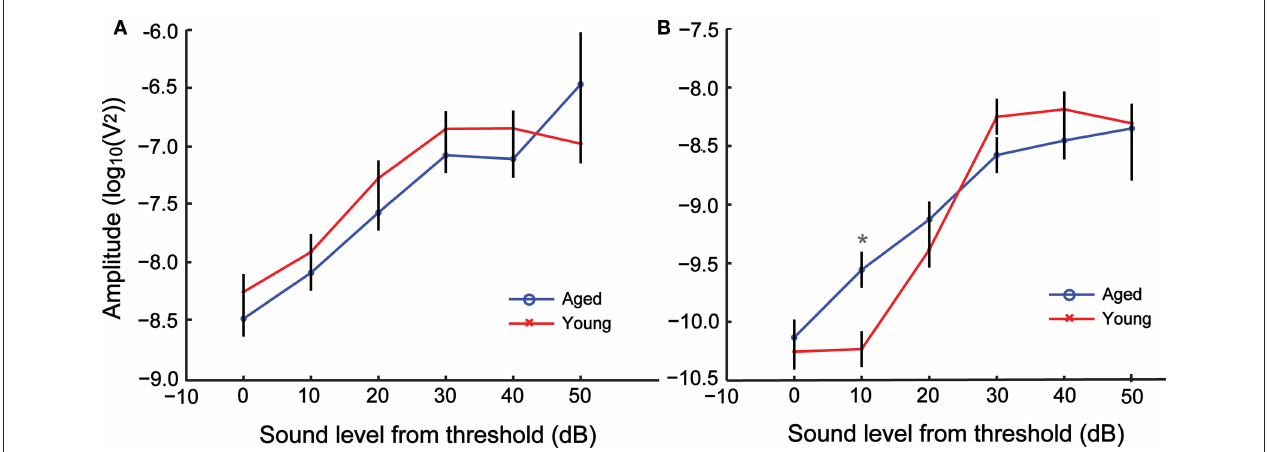
Figure 4 | AMFr amplitudes with increase in sound level for 256 (A) and 1024 Hz (B) AM shows no difference in amplitude between young and aged animals for nearly all sound levels when plotted relative to individual click ABR threshold. The x axis indicates sound level relative to threshold, with 0 representing click ABR threshold. The y axis indicates the LSM ± SE of the FFT amplitudes. Asterisks indicate statistically significant difference in LSMs ( P < 0.05, MANOVA).